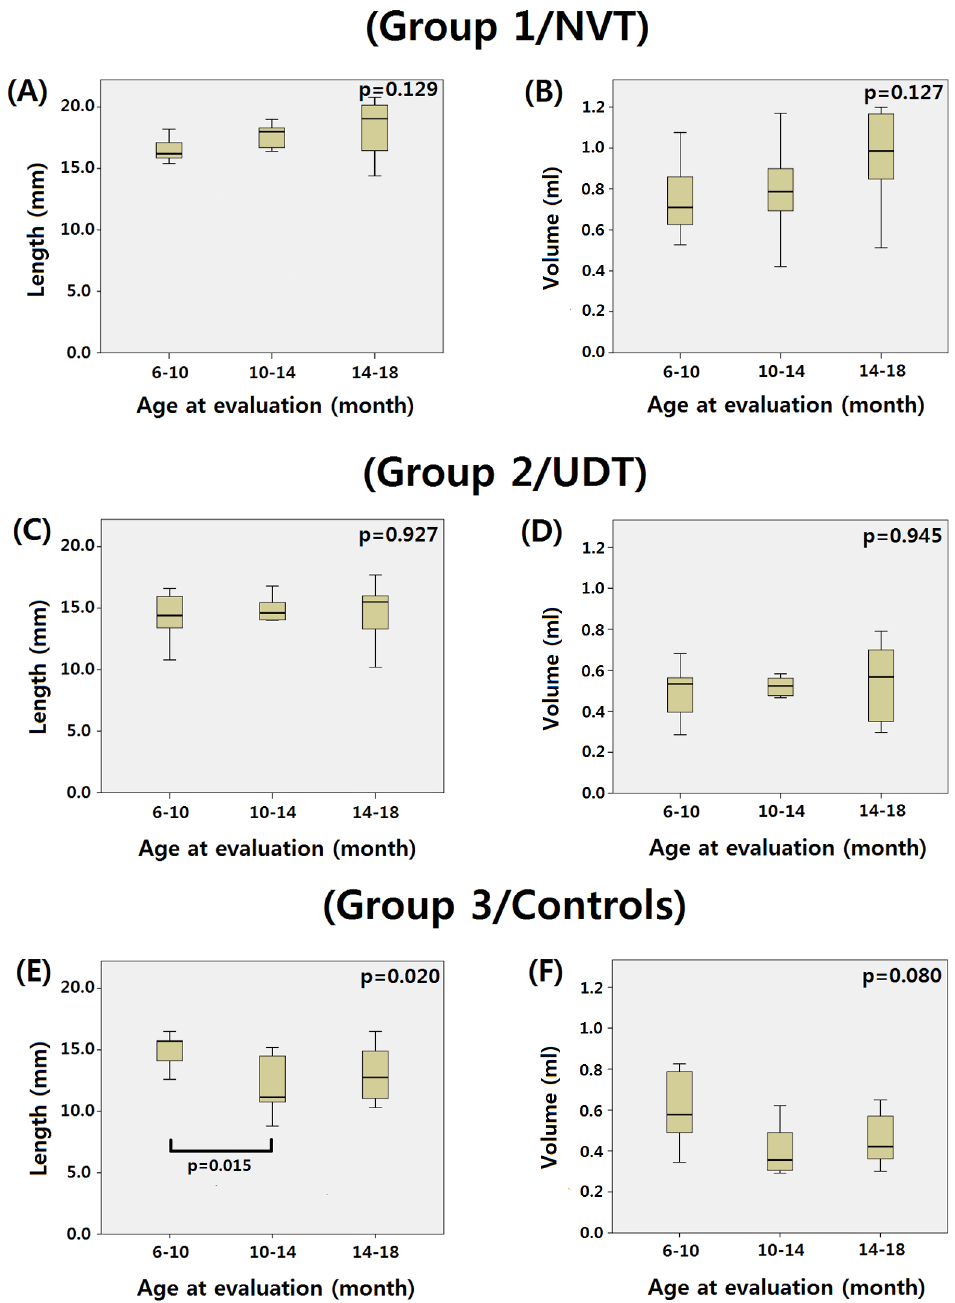
Fig 2. The variation of testicular length and volume during infancy by the effect of mini-puberty was absent in both NVTs and UDTs. In group 1 (NVT) (A-B) and group 2 (UDT) (C-D), there was no significant difference in testicular length or volume during any of the three periods assessed. In group 3 (controls), the length of the testes was significantly longer in infants at 6 – 10 months than at 10 – 14 months (E). The median testicular volume of the control group in infants at 6 – 10 months was larger than at 10 – 14 months, though without statistical significance